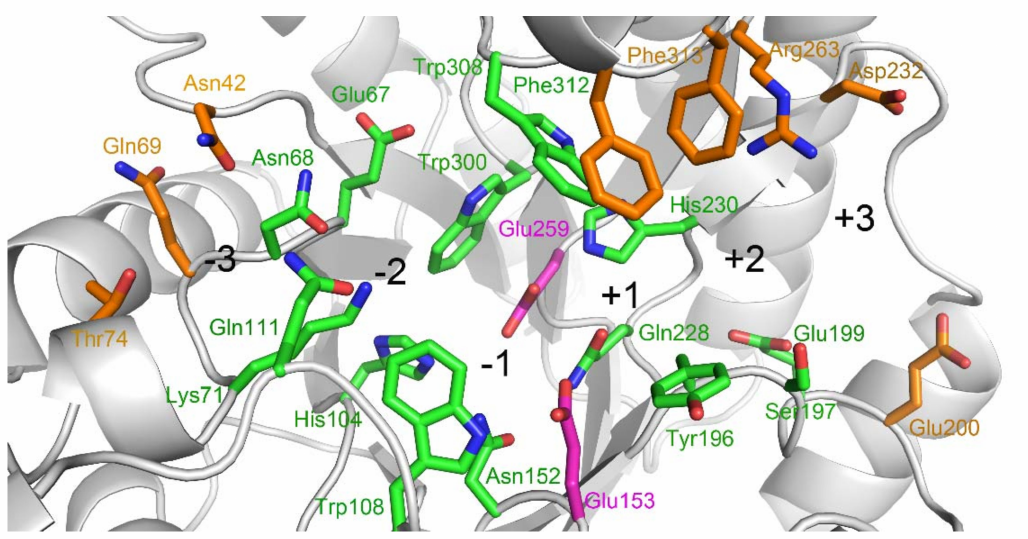
Figure 1. Substrate-binding cleft of xylanase from Thermotoga maritima (TmxB). The putative subsites are indicated by the large black numbers. The amino acids constituting each subsite are shown. The colors of the carbon atoms of the catalytic acid/base Glu153 and nucleophile Glu259 are shown in magenta. For the other amino acids, the colors of the carbon atoms are shown according to their degree of conservation, with green and brown for conserved and variable amino acids,